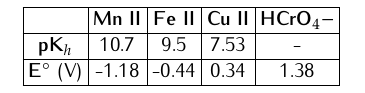
Table 5. Hydrolysis constant pKh and electrode potential related to used heavy